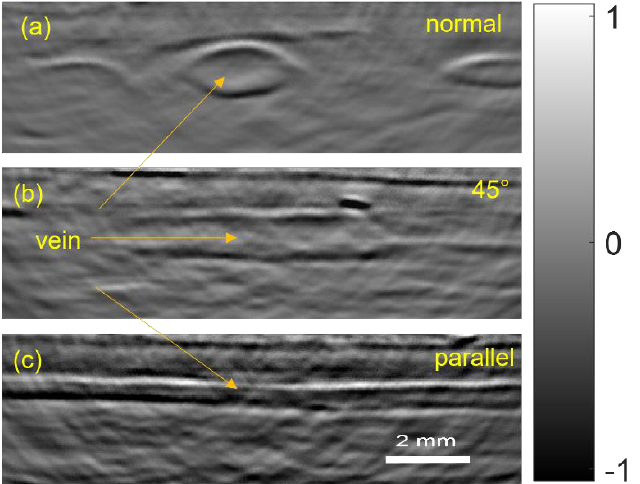
Figure 9. A vein in the wrist at three different probe orientations. When the long axis of the probe is ( a ) normal to the direction of the vein, the cross-section is imaged, and when it is parallel to the vein ( c ), a longitudinal image of the vein is obtained. When the probe is positioned at an angle of 45 ◦ ( b ), the resulting image combines the features of the two abovementioned cases. The scale bar in subfigure ( c ) applies to all